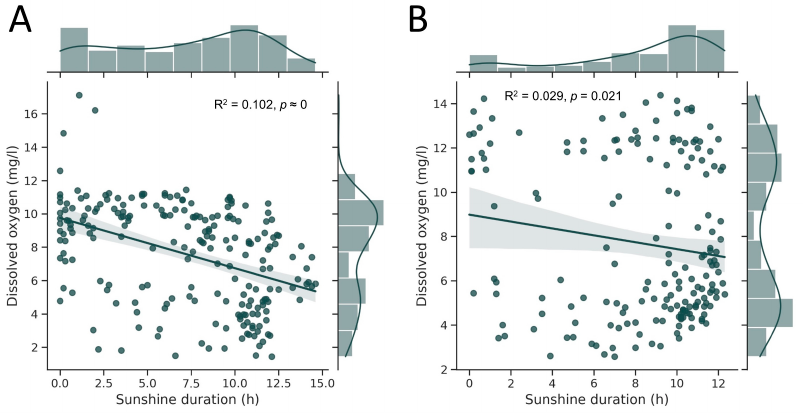
Figure 11. ( A , B ) Regression plot of DO and sunshine duration in 2017 and 2021,